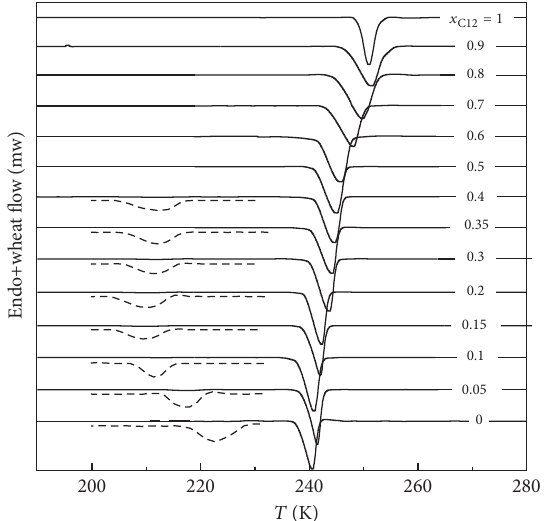
F 8: DSC curves of C (17.2nm) as a function of mole fractions of . From 200 to 230K, the solid-solid transitions are enlarged as the dash lines, next to the main DSC curves at